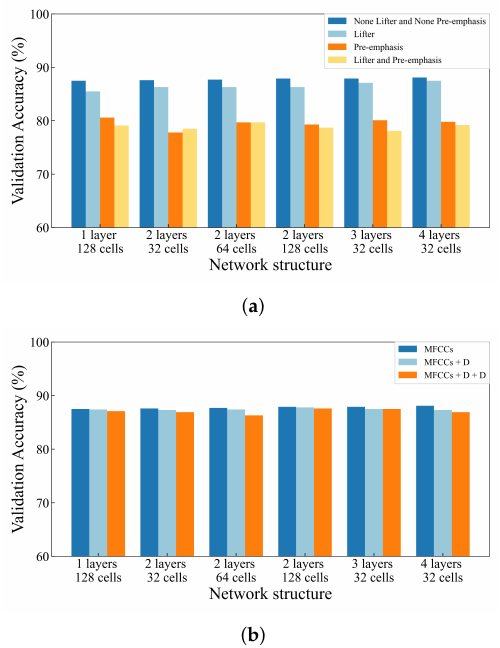
Figure 9. Validation accuracy of each model with different hand-crafted feature parameters: ( a ) The effects of inverse spectrum boosting and pre-Emphasis; ( b ) influence of temporal first and second derivatives. Note : (1) learning rate = 0.001, dropout = 0.5; (2) lifter: sinusoidal lifter applied to produce filtered MFCCs and n = 26; (3) pre-emphasis: pre-emphasis applied on the signal and µ = 0.97; (4) MFCCs + D: MFCCs with 12 coefficients and energy along with their temporal first derivatives; (5) MFCCs + D + D: MFCCs with 12 coefficients and energy along with their first and second